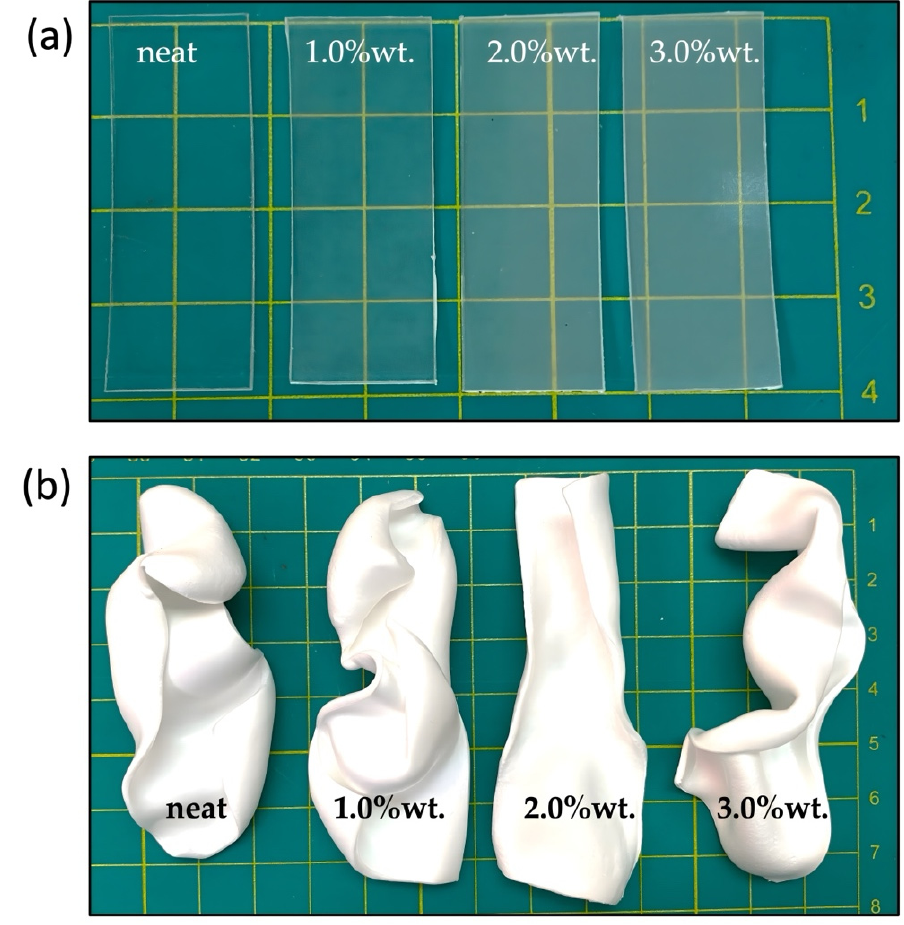
Figure 2. PLA and PLA/C30B bionanocomposite films ( a ) and foams ( b